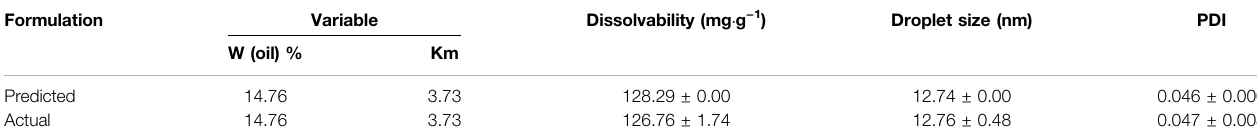
TABLE 7 | Predicted and observed response for optimized LFs microemulsion composition.